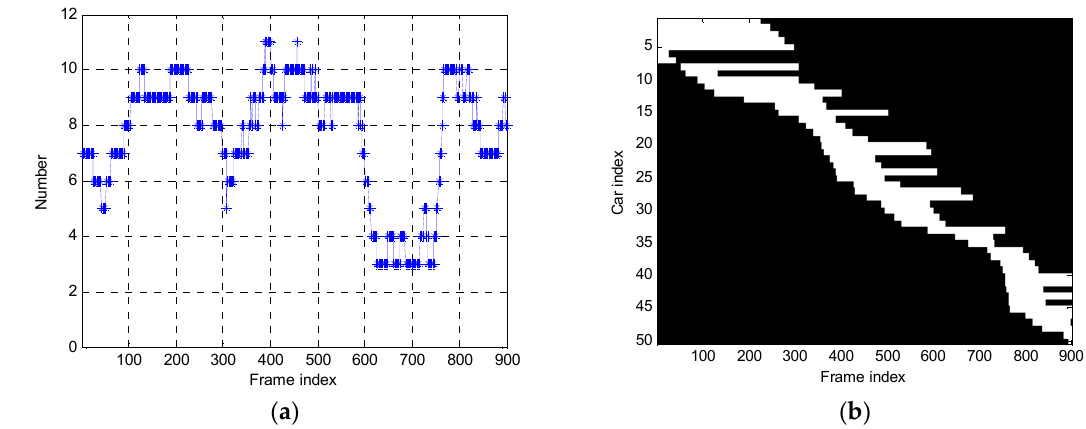
Figure 4. Results of marking of moving cars in the SNL VideoSAR data. ( a ) Number of moving cars. ( b ) Motion of moving cars.